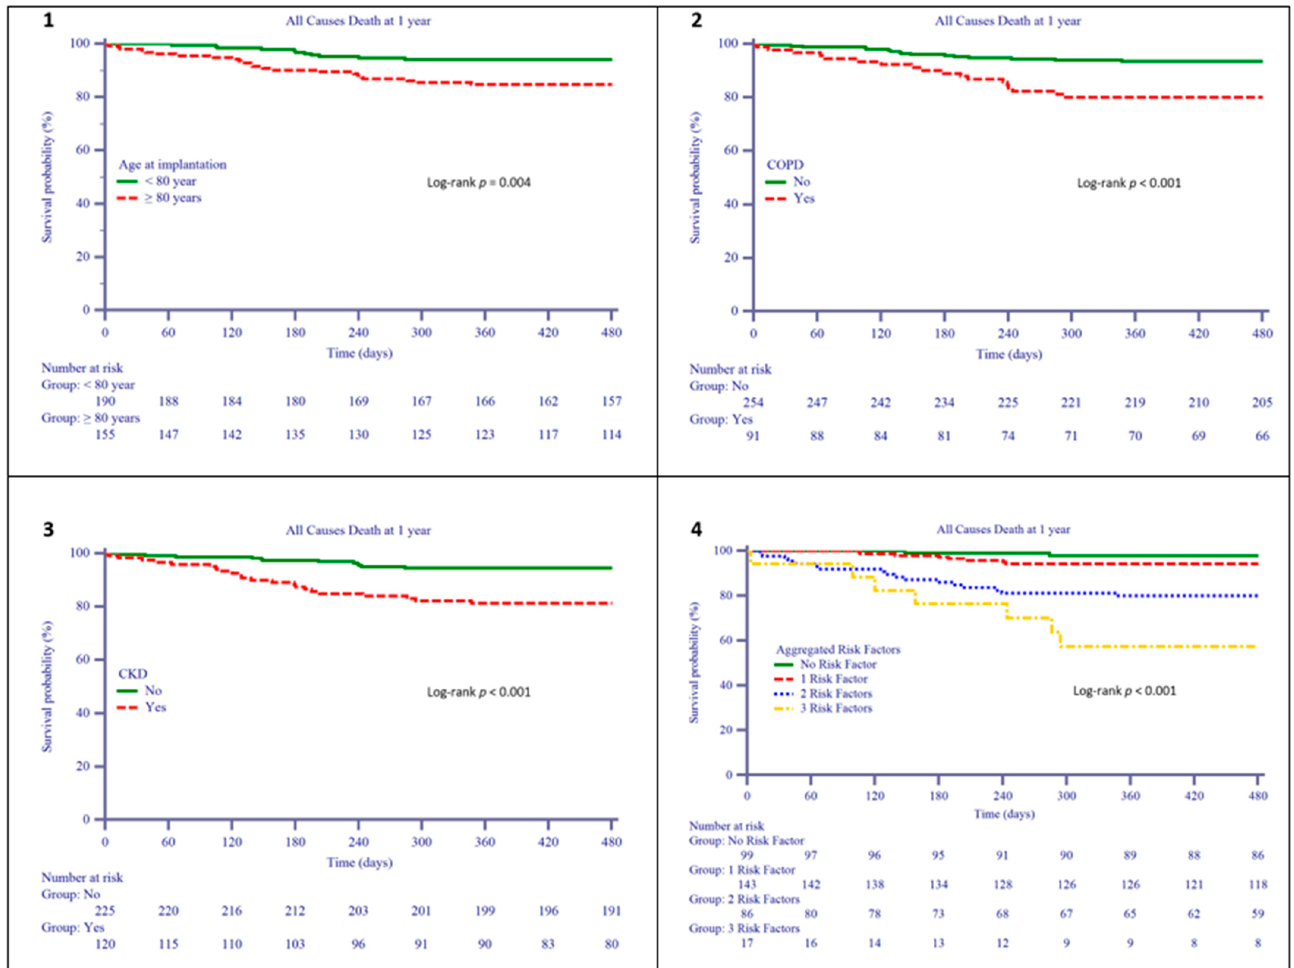
Figure 2. Predictors of death at 1 year in the elderly group. ( 1 ) All cause death in patients above and below 80 years old; ( 2 ) All cause death in patients with and without COPD; ( 3 ) All cause death in patients with and without CKD; ( 4 ) All cause death in patients with 1-2-3 or none of the abovementioned risk factors.The Kaplan–Meier curves show the reduction in survival in patients aged > 80 years (left upper panel), in patients with COPD (right upper panel) and in patients with CKD (left lower panel). Patients with all three factors have the lowest survival (right lower panel). COPD: chronic obstructive pulmonary disease; CKD: chronic kidney